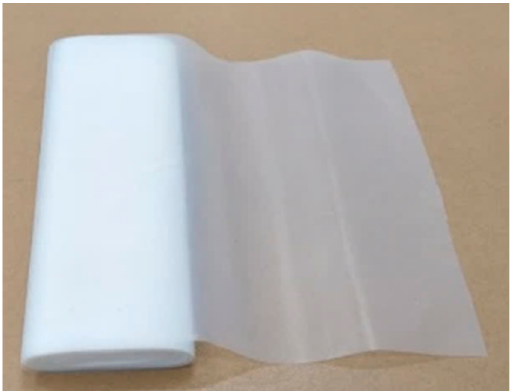
Figure 9. Polytetrafluoroethylene (PTFE) films with a thickness of 40